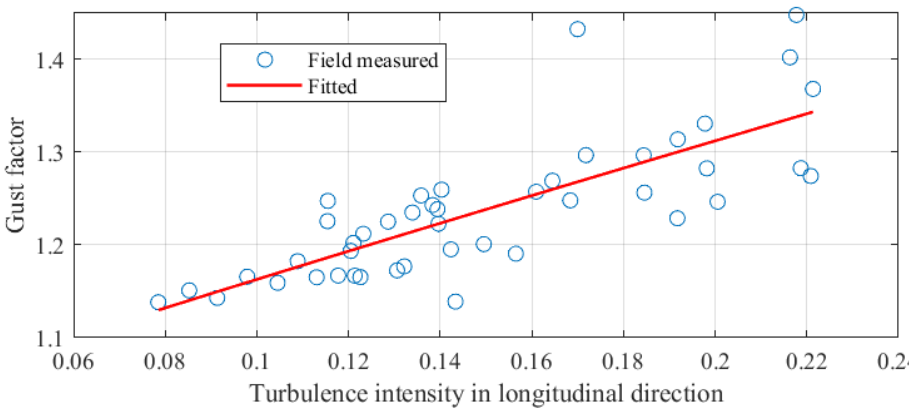
Figure 7. Relationship between gust factor and longitudinal turbulence intensity.